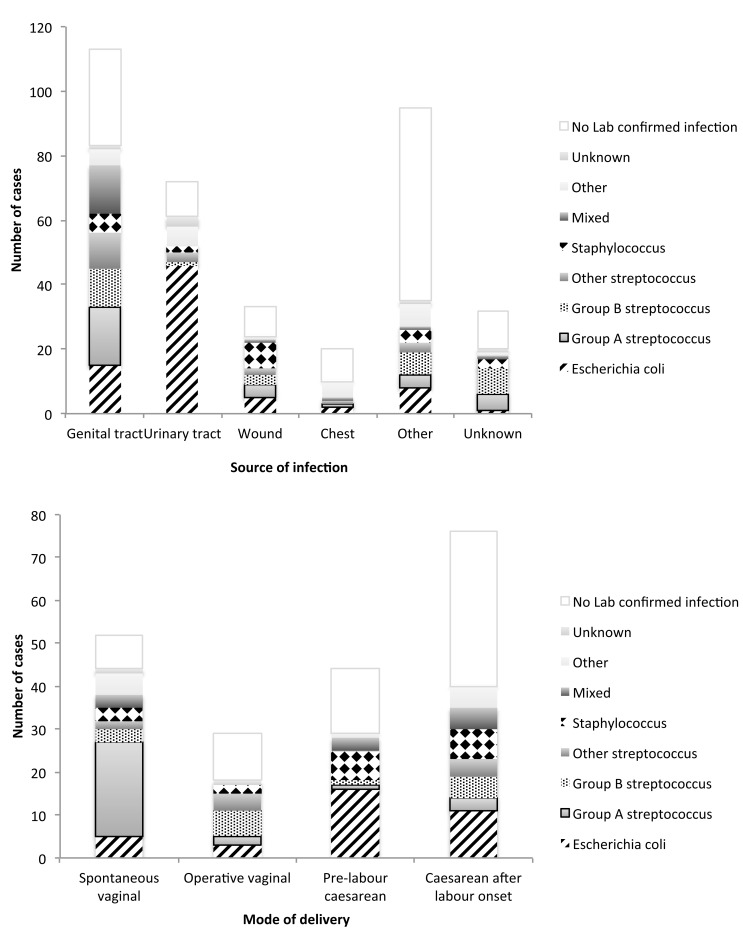
Distribution of causative organisms according to source of infection and mode of delivery.Stacked bars represent the number of cases with specific causative organisms according to infection source and mode of delivery categories. Data are mutually exclusive.